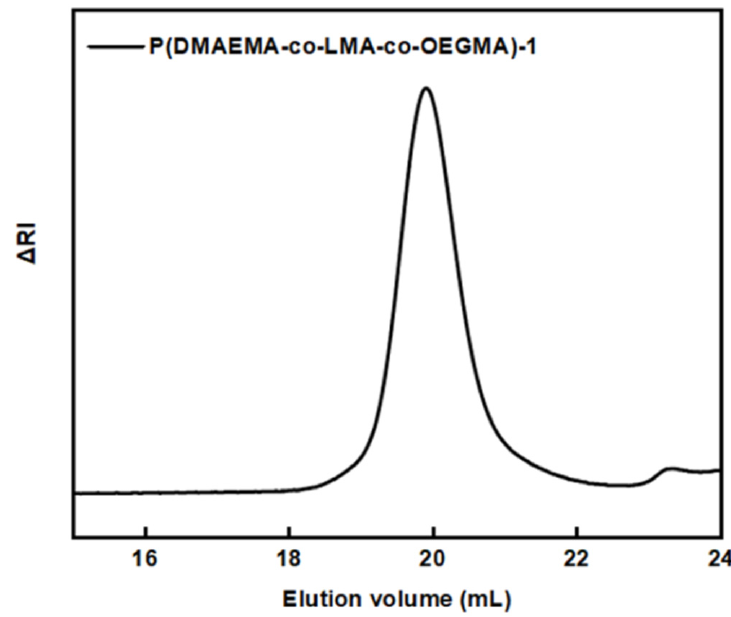
Figure 1. SEC chromatogram for TER-1